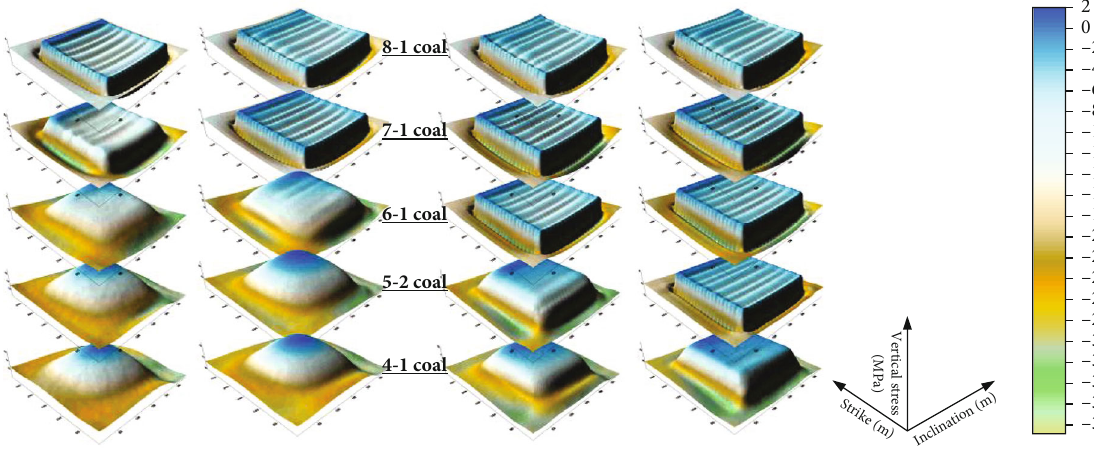
Figure 7: Vertical stress distribution of closed coal seams with downward multi-seam